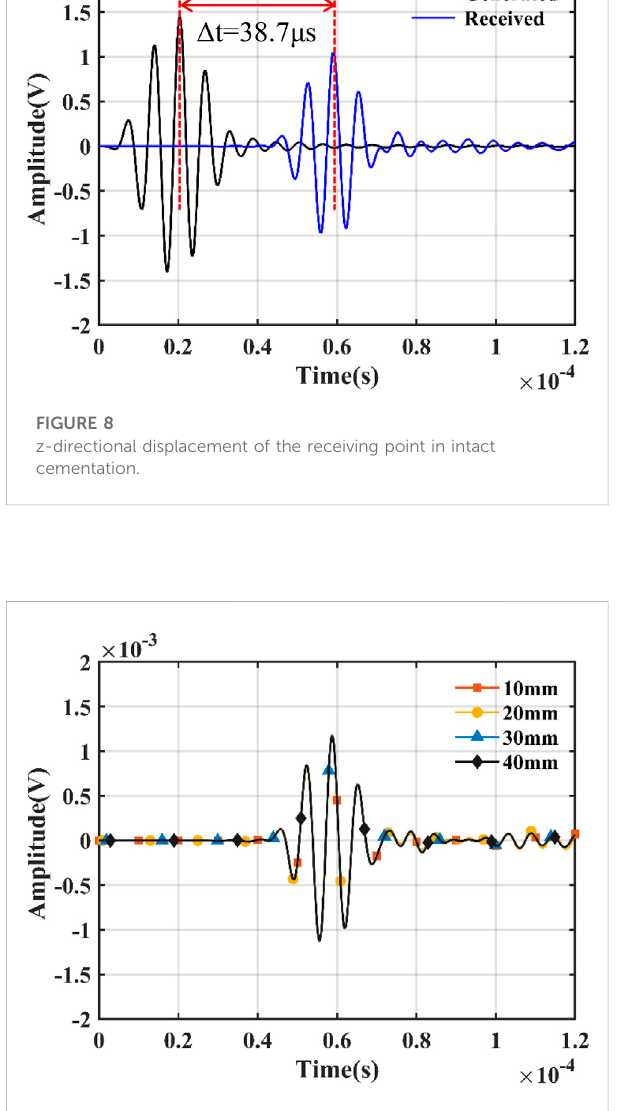
FIGURE 9 Simulation results of cement bonding defects at different radial depths.